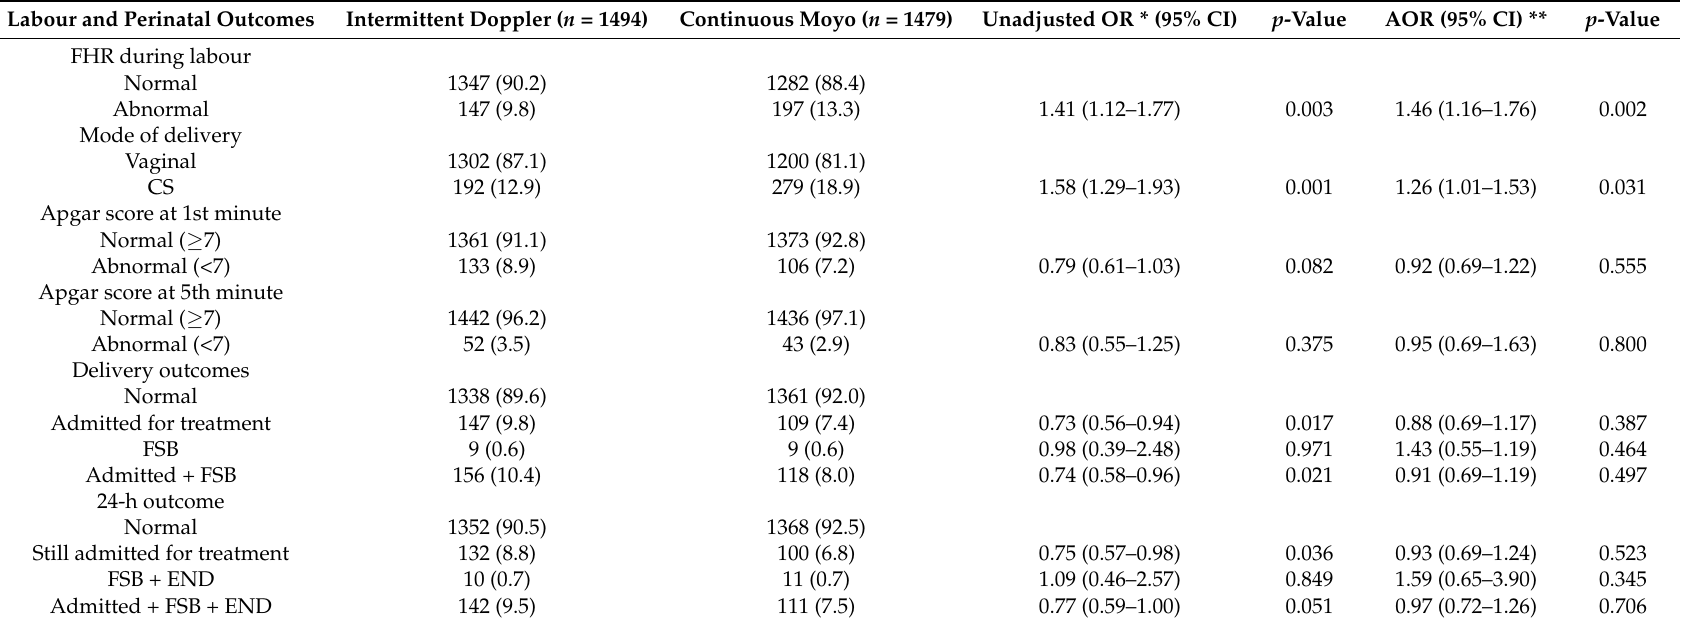
Table 2. Comparison of labour and perinatal outcomes between intermittent Doppler and continuous